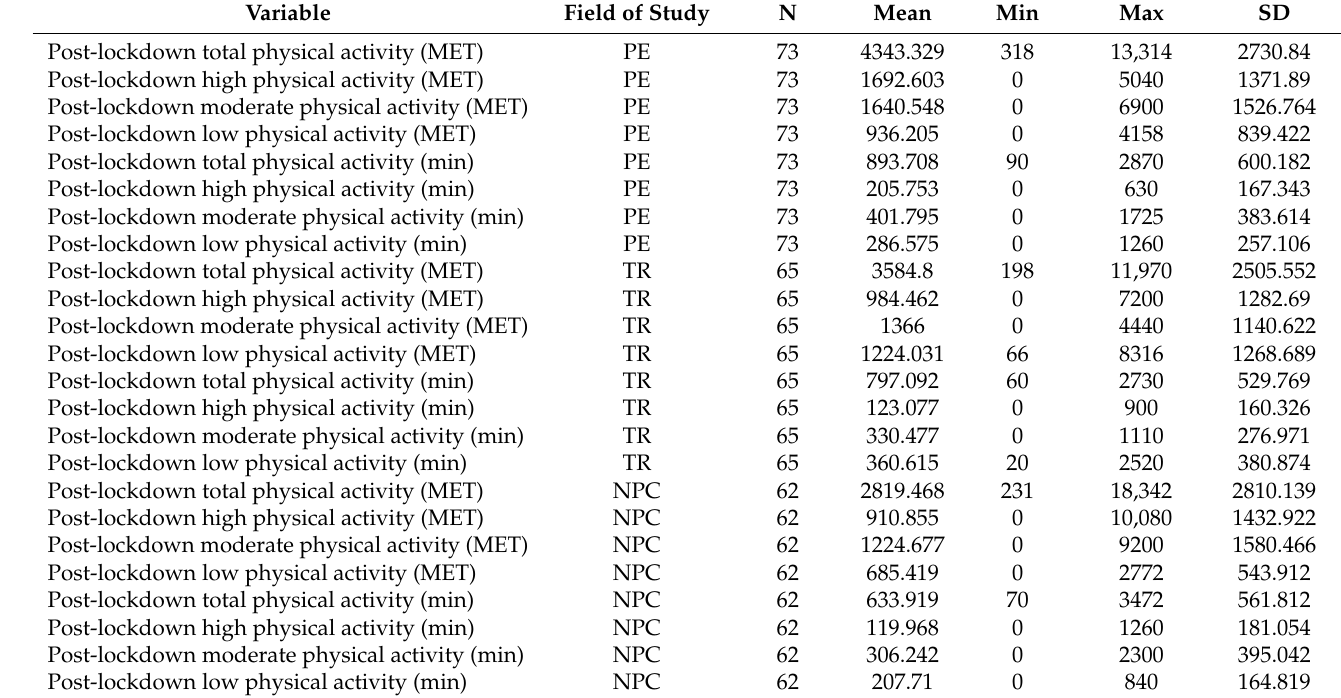
Table 2. MET scores and time spent in physical activity during the post-lockdown period.